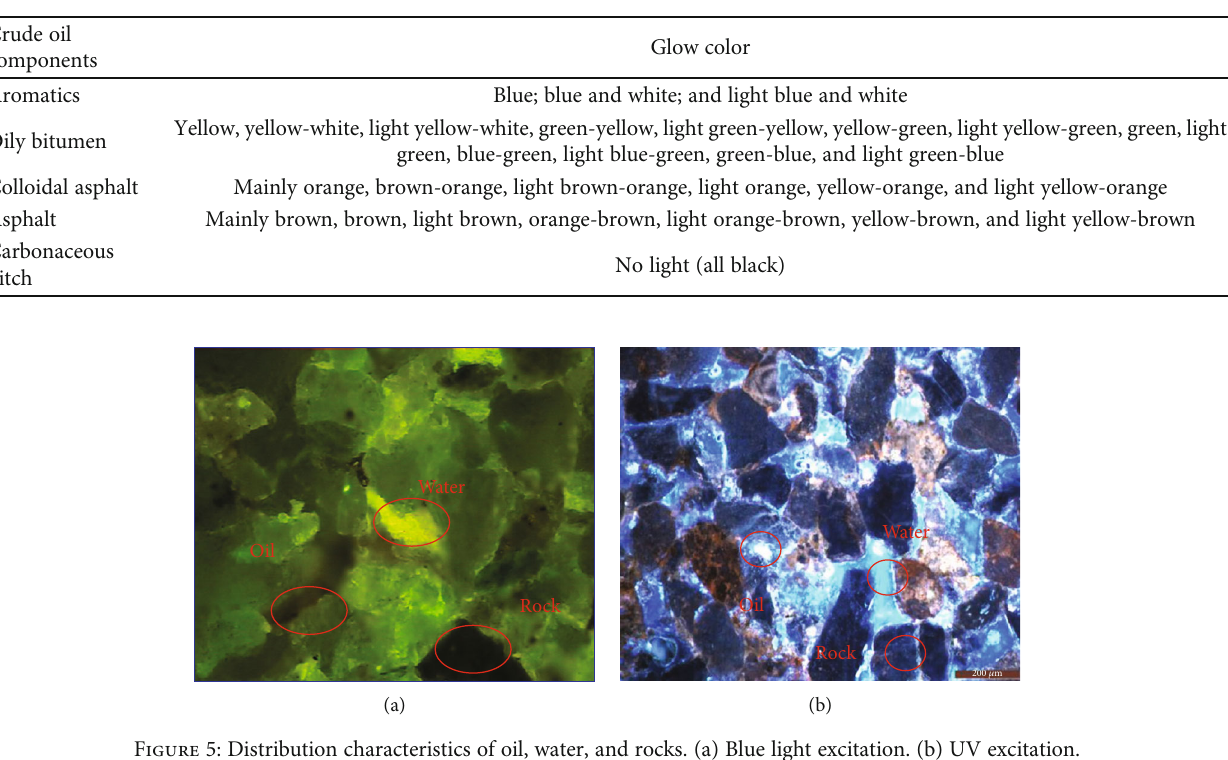
Figure 4: Principle and three-dimensional reconstruction of laser confocal scanning microscope. (a) Schematic. (b) XY plane scanning at di ff erent z -axis positions. Table 3: Relationship between luminous color and crude oil composition.